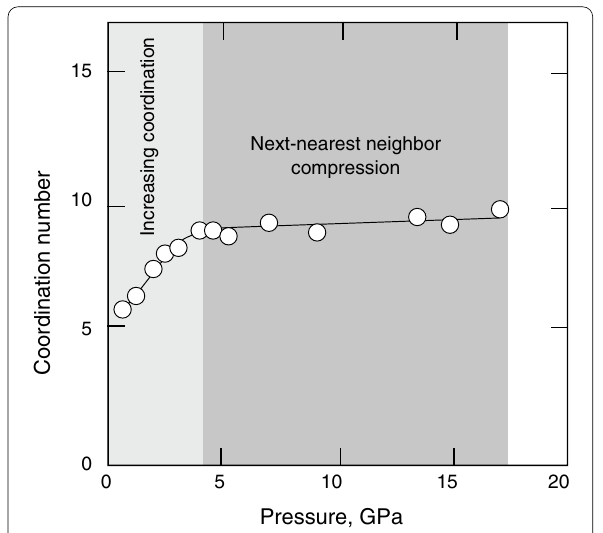
Fig. 30 Oxygen coordination number of H 2 O as a function of pressure. Modified rom Katayama et al. (2010)